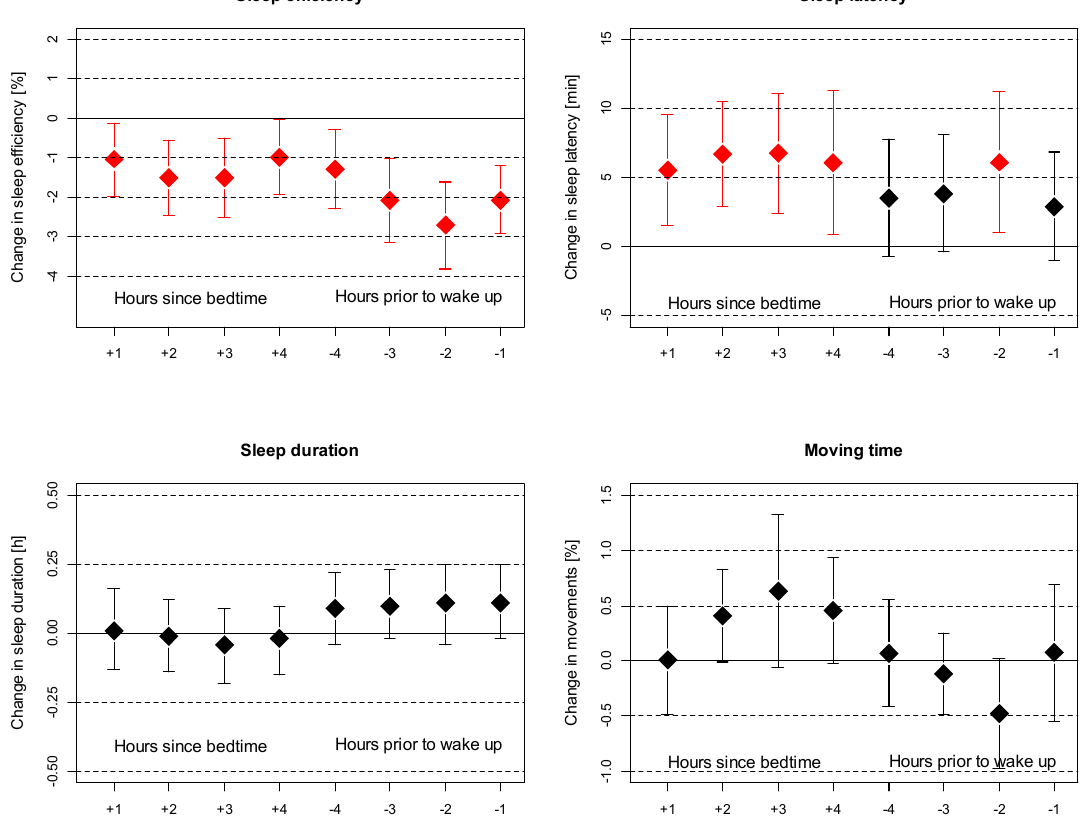
Figure 2. Association between actimetry-derived outcomes and outdoor noise exposure for each hour after bedtime ( + ) or noise exposure for each hour prior to wake-up ( − ). Changes refer to a 10 dB(A) increase in noise exposure in the respective hour. Same adjustments as indicated in Figure 1.